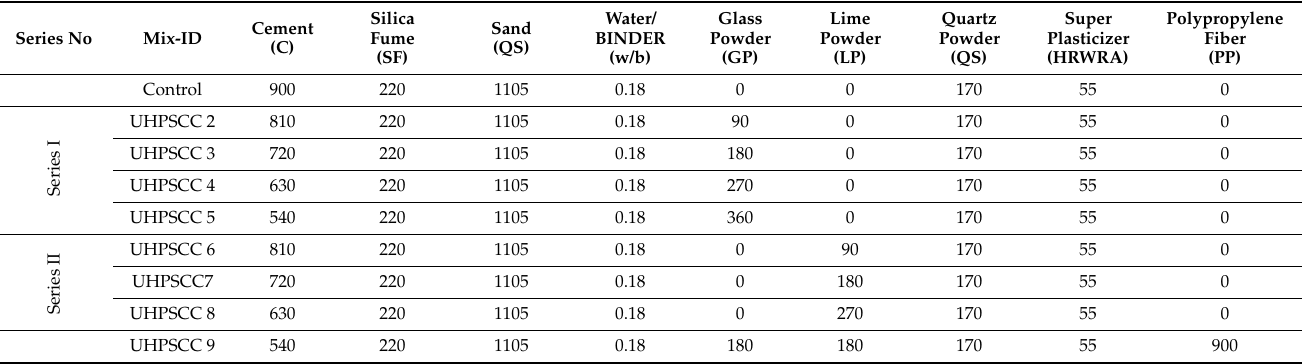
Table 2. Concrete mixture properties (in kg/m 3